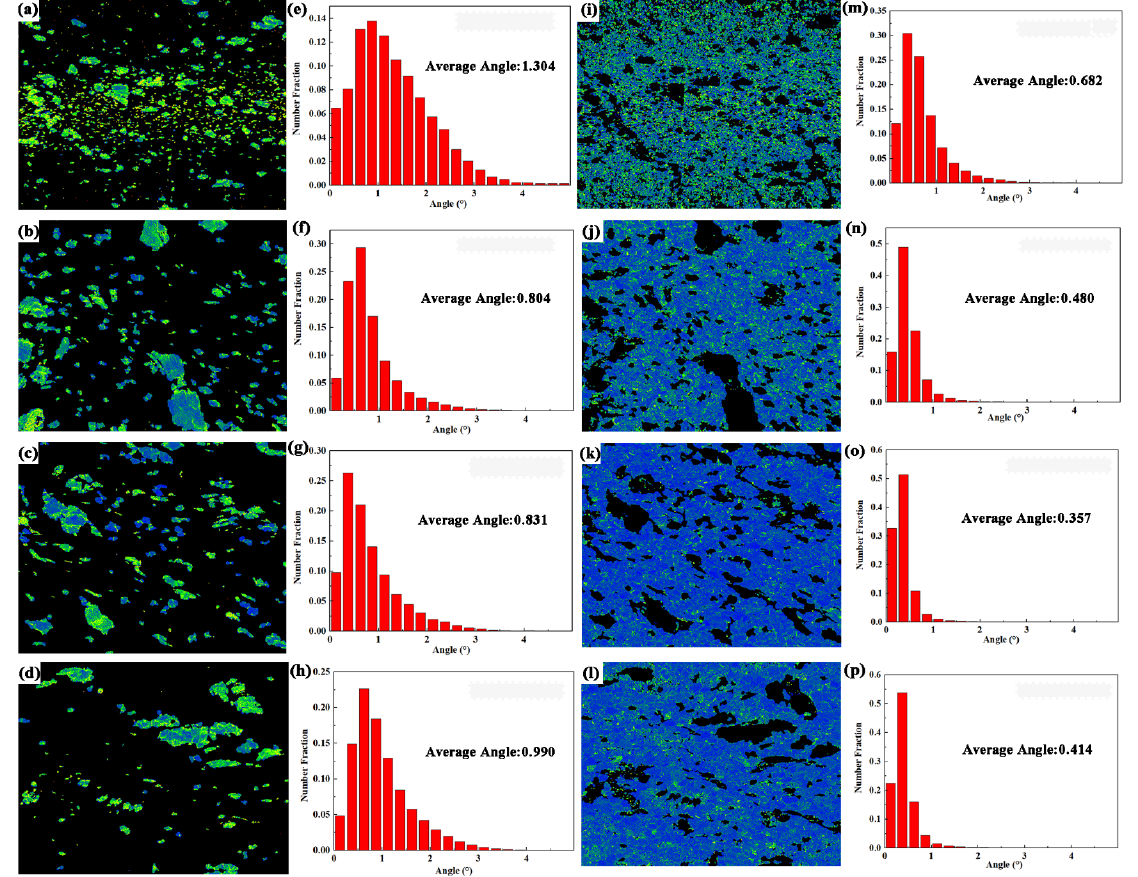
Figure 15. KAM maps and the distribution curve of the deformed grains: ( a , e ) initial samples; ( b , f ) L-653 sample; ( c , g ) L-743 sample; ( d , h ) H-743 sample. KAM maps and the distribution curve of the DRX grains: ( i , m ) initial samples; ( j , n ) L-653 sample; ( k , o ) L-743 sample; ( l , p ) H-743